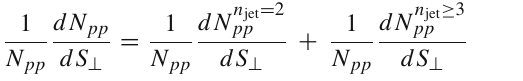
Fig. 6 Relative contribution fraction of total event number normalized transverse sphericity distribution of n jet = 2, n jet ≥ 3 events in p+p √ s = 5 . 02 TeV collisions at